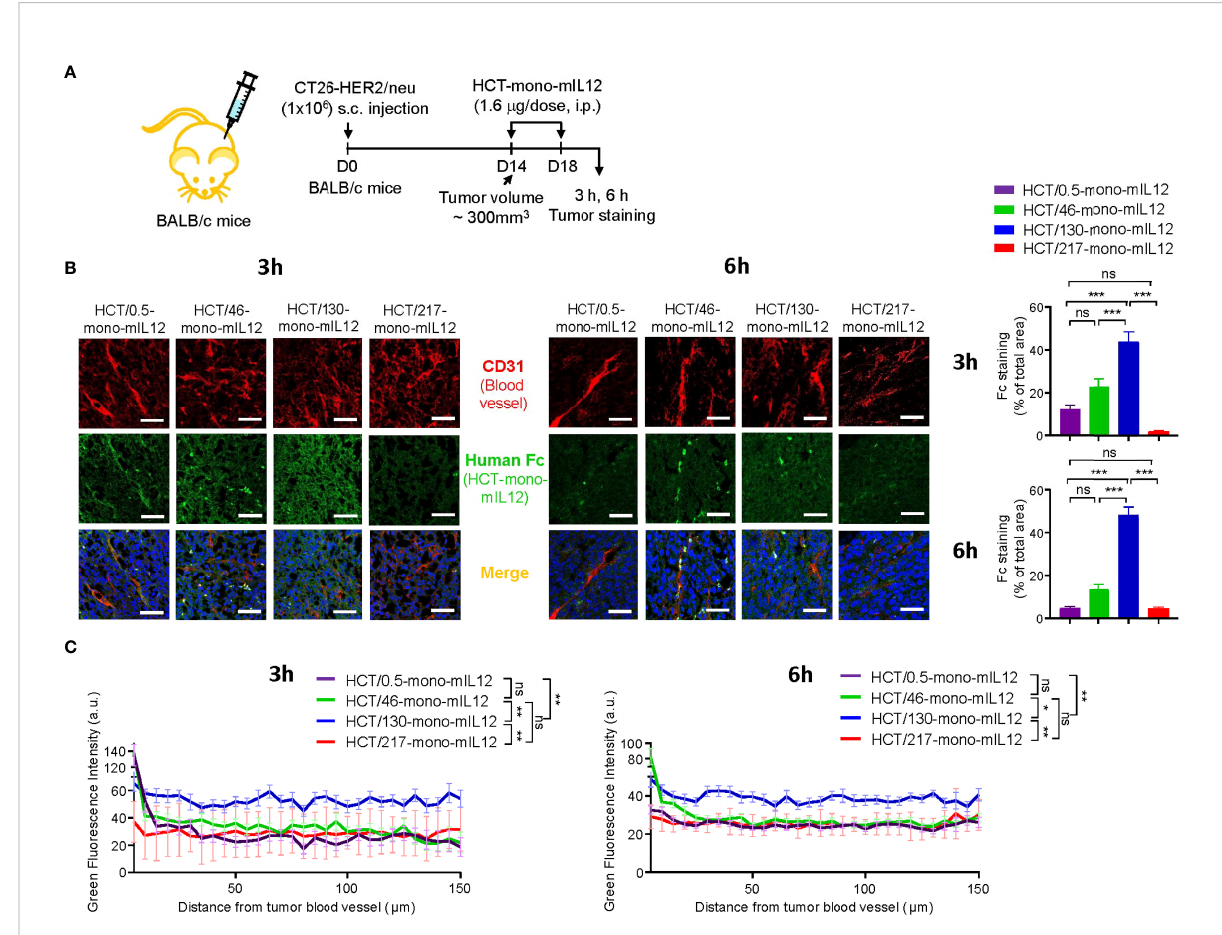
FIGURE 4 Intratumoral penetration of HCT-mono-mIL12 depends on its anti-HER2 binding kinetics. (A – C) Treatment scheme of CT26-HER2/neu – tumor- bearing mice initiated at a tumor volume of ~300 mm 3 with i.p. injection of HCT-mono-mIL12 at 1.6 m g per dose (an equimolar amount of 0.5 m g rmIL12 per dose) two times, on days 14 and 18 after tumor inoculation (A) , to determine the intratumoral penetration of HCT-mono-mIL12 in tumor tissues excised from the mice at 3 h or 6 h after the second dosing on day 18 by IF staining (B) and for quanti fi cation of the fl uorescence intensity from the nearest blood vessel in the tumor section (C) . In (A) , the arrows indicate each time point for treatment or assay. (B) Representative IF images depicting intratumoral diffusion of HCT-mono-mIL12 (human Fc staining with FITC, green) in relation to the blood vessels (CD31 staining with TRITC, red). Blue represents nuclei staining. Image magni fi cation, ×200; scale bar, 50 m m. Right , quanti fi cation of positive areas of Fc staining (green) analyzed by ImageJ software. (C) Fluorescence intensity of HCT-mono-mIL12 in (B) quanti fi ed according to the distance from the nearest blood vessel in the tumor tissues. Each line represents the value of fl uorescence intensity averaged every 5 m m. In (B, C) data represent mean ± SEM of four fi elds per tumor (n = 3 per group). *p < 0.05, **p < 0.01, ***p < 0.001 between the indicated groups; ns, not signi fi